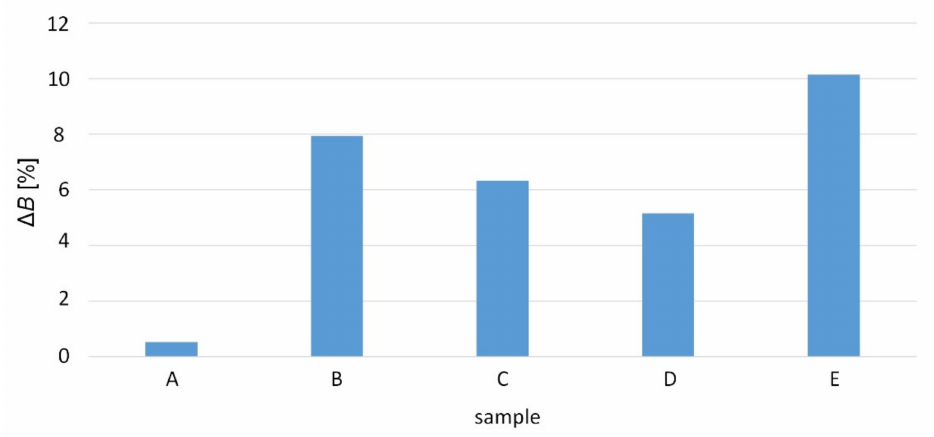
Figure 8. The comparison of simulated values of B-field in CST Studio Suite and measured values of B-field obtained by Narda NBM-550 in exposure coil.